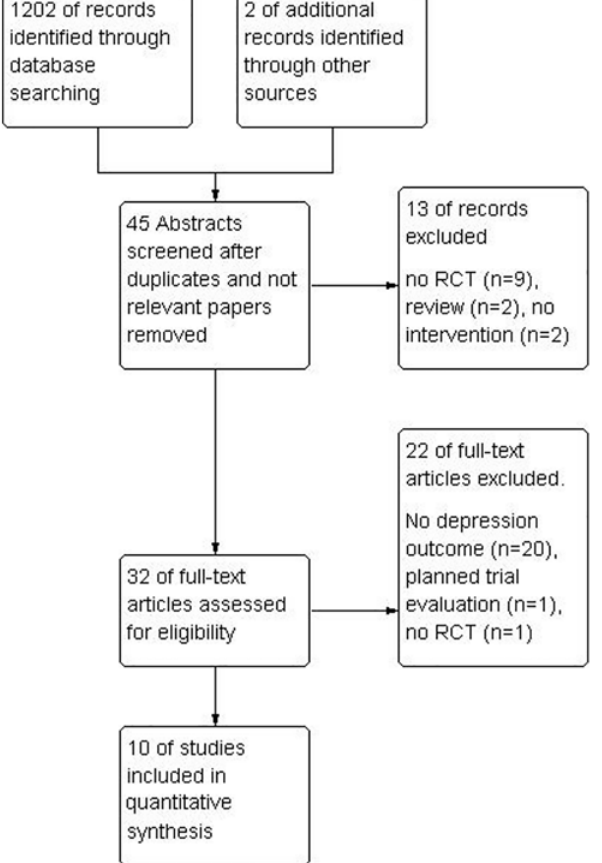
Fig 1. Flow diagram of the selection of